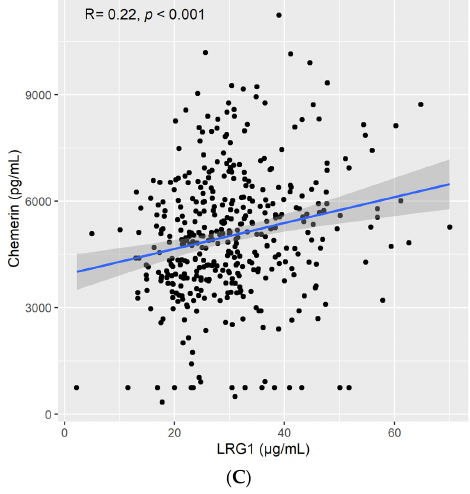
Figure 2. Correlation between LRG1 and ( A ) high sensitivity C-reactive protein (hsCRP), ( B ) leptin, and ( C ) chemerin.